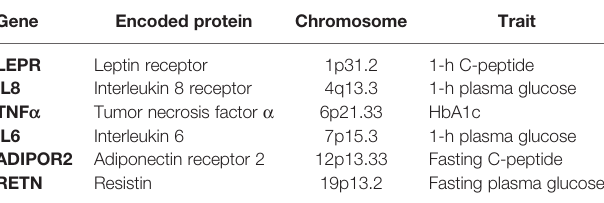
TABLE 2 | In fl ammatory pathway genes associated with maternal metabolism (29). Gene Encoded protein Chromosome